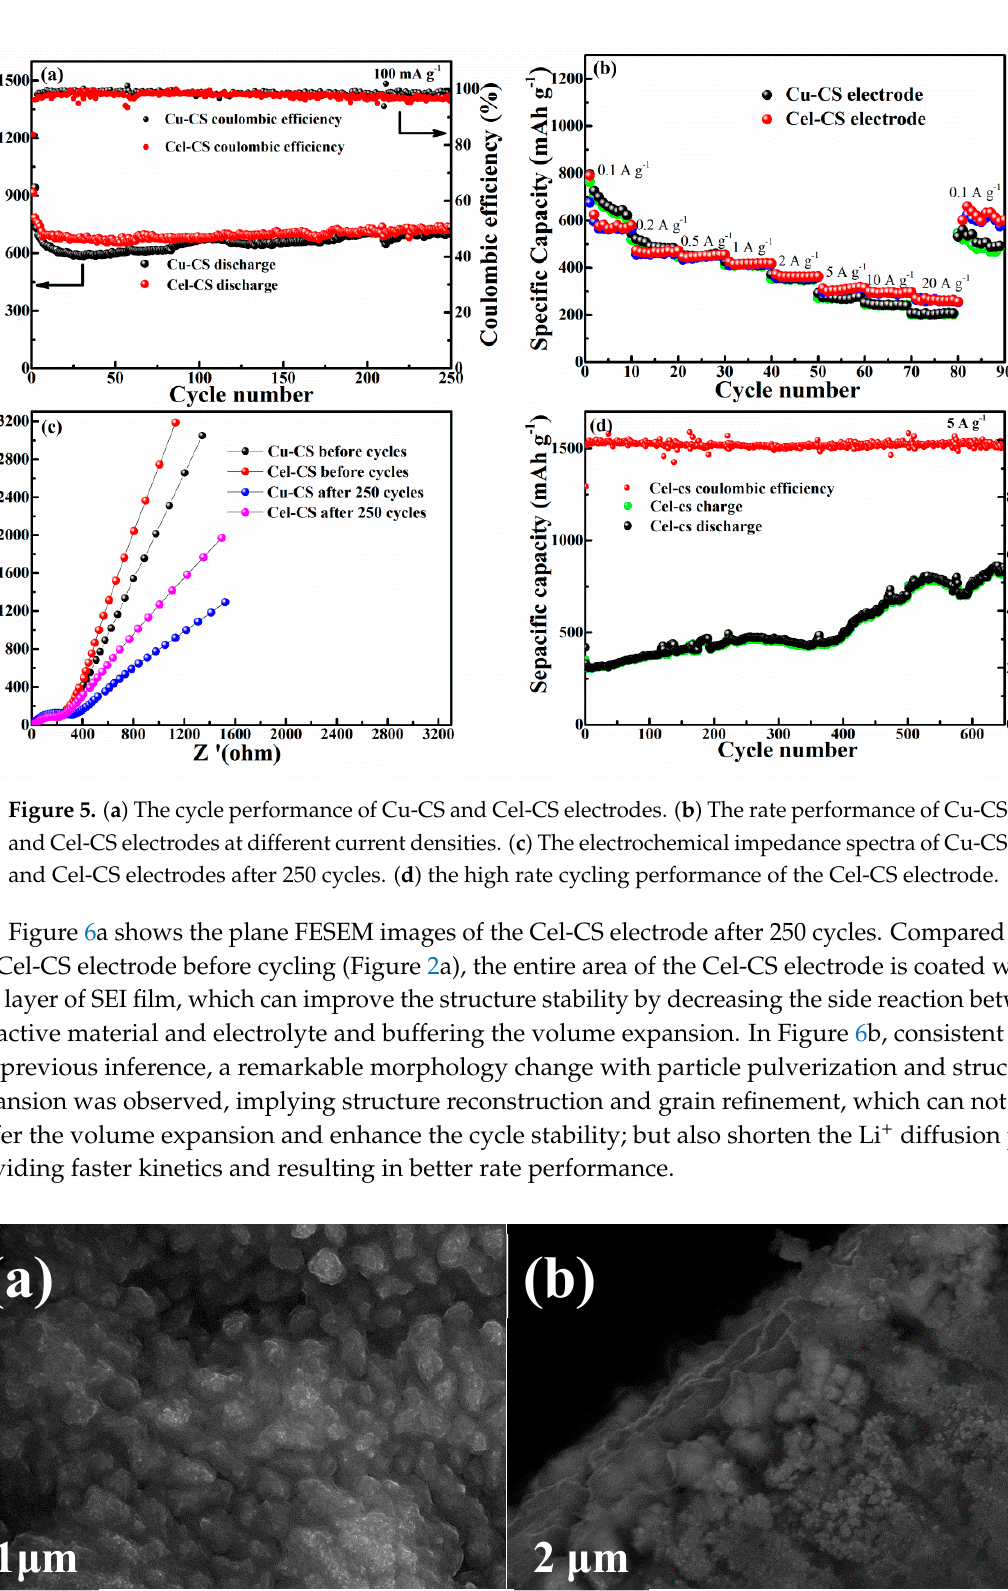
Figure 6. The plane ( a ) and section ( b ) FESEM images of the Cel-CS electrode after 250 cycles.